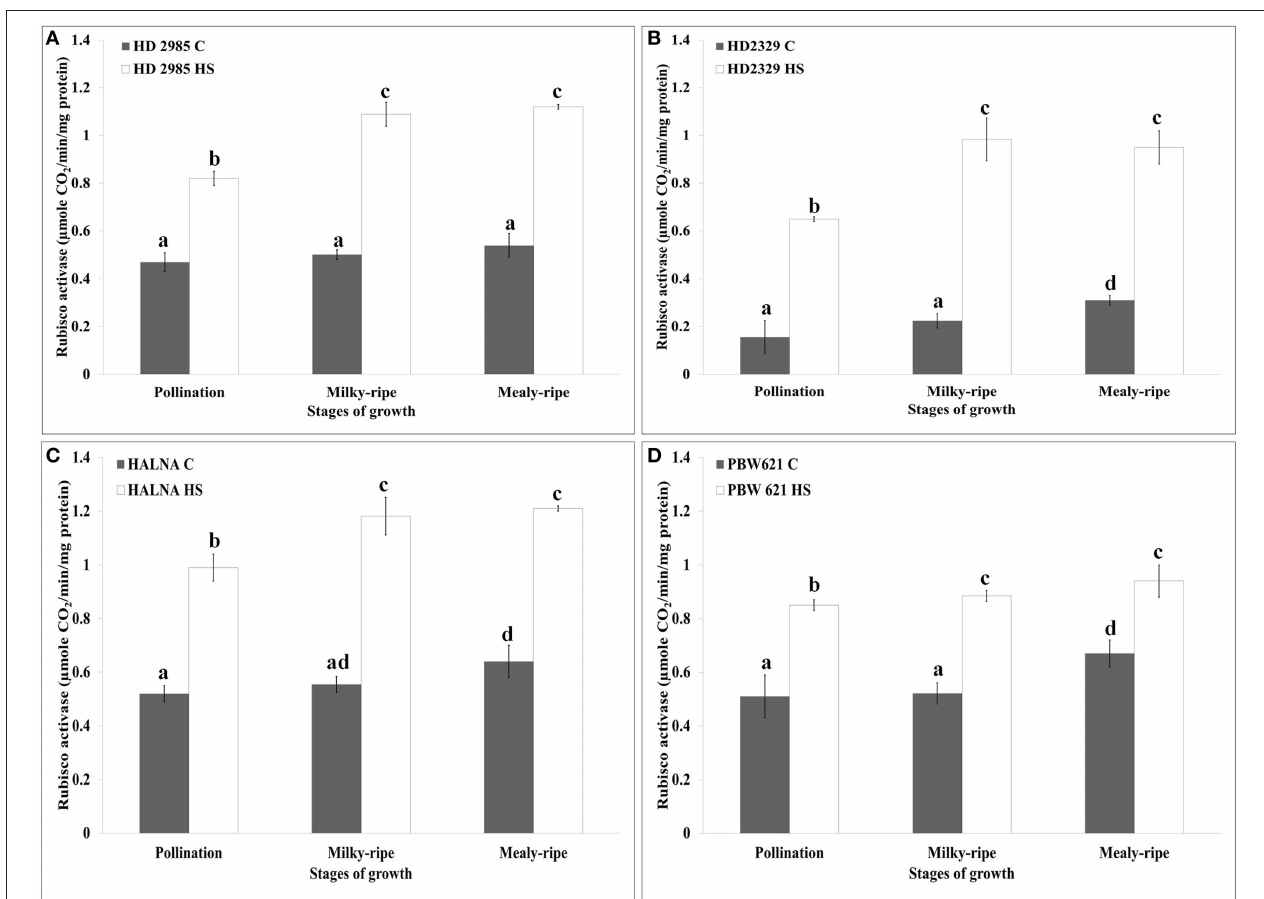
FIGURE 6 | RuBisCo activase (Rca) activity assay in contrasting wheat cultivars at different stages of growth and development under control (C) and heat stress (HS) conditions. (A) HD2985 (C and HS), (B) HD2329 (C and HS), (C) Halna (C and HS), (D) PBW621 (C and HS); samples collected from pollination, milky-ripe and mealy-ripe stages were used for the activity assay; C − 22 ± 3 ◦ , heat stress − 42 ◦ C for 2 h; NaH 14 CO 3 (20mM, specific activity 50 mCi mmol − 1 , BARC, Mumbai) was used for the labeling; different letters above each bar indicate a significant difference ( p < 0.05 ) between the treatments (one-way ANOVA); vertical bars indicate SE ( n = 3